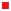
Exemplary presentation of exercise parameters.[A] Performance of a 20-year-old female participant. Participant’s individual anaerobic threshold (IAT) was 11.2 km·h-1 (upper level compared to sex-specific mean). [B] Performance of a 21-year-old female participant. Participant’s individual IAT was 9.7 km·h-1 (lower level compared to sex-specific mean). [C] Performance of a 21-year-old male participant. Participant’s IAT was 11.1 km·h-1 (upper level compared to sex-specific mean). [D] Performance of a 24-year-old male participant. Participant’s IAT was 9.8 km·h-1 (lower level compared to sex-specific mean). Exercise heart rate (HR, ■) and blood lactate concentration (LA, ●) are shown at the different Incremental Continuous Running Test (ICRT) stages given as km·h-1. IAT is represented as vertical blue line.